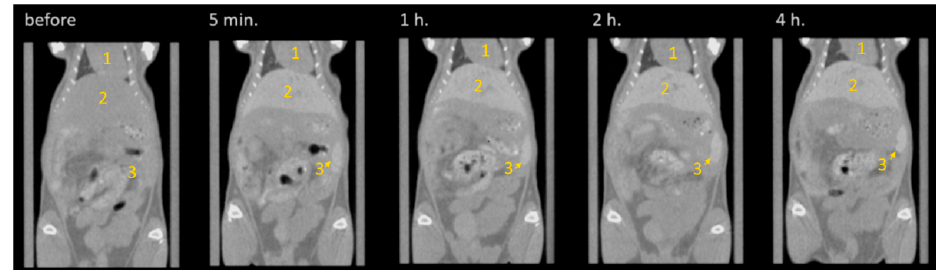
Figure 4. CT images taken before (left) and with different intervals after injection of PEG-capped GdF 3 :Tb 3+ NPs. Different organs are denoted in the images: 1—heart, 2—liver, 3—spleen; the kidney is not visible within the selected 2D slice. All the rest of the structures observed in the abdominal area represent the organs of the gastrointestinal tract and bladder, which provide notable contrast also before NPs’ administration (see left panel—“before”).